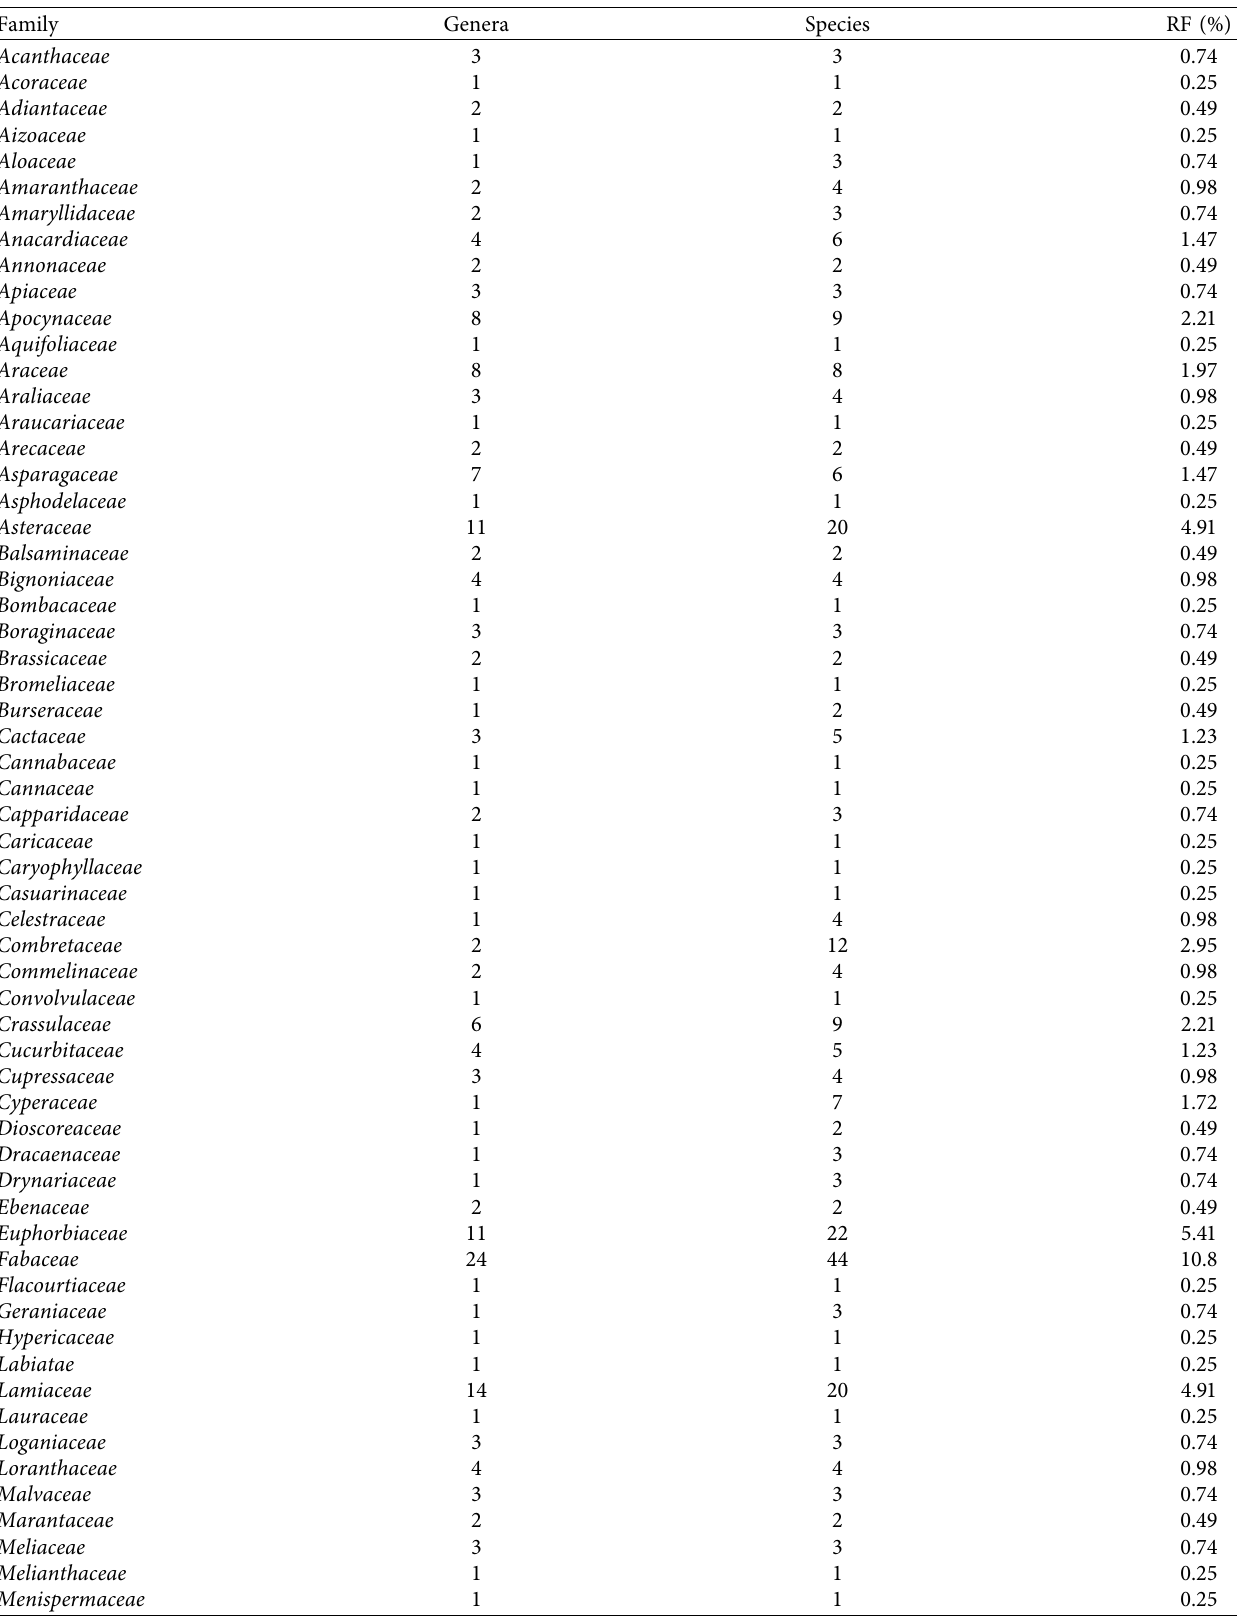
Table 1: Te number of families, genera, and species of plants in DUBEG (RF � relative